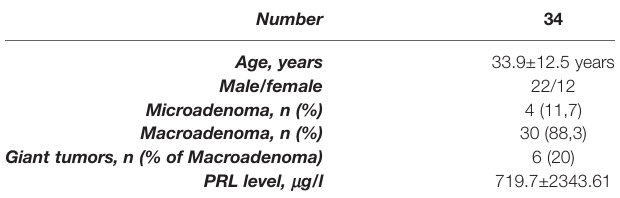
TABLE 1 | Patient pro fi les at study